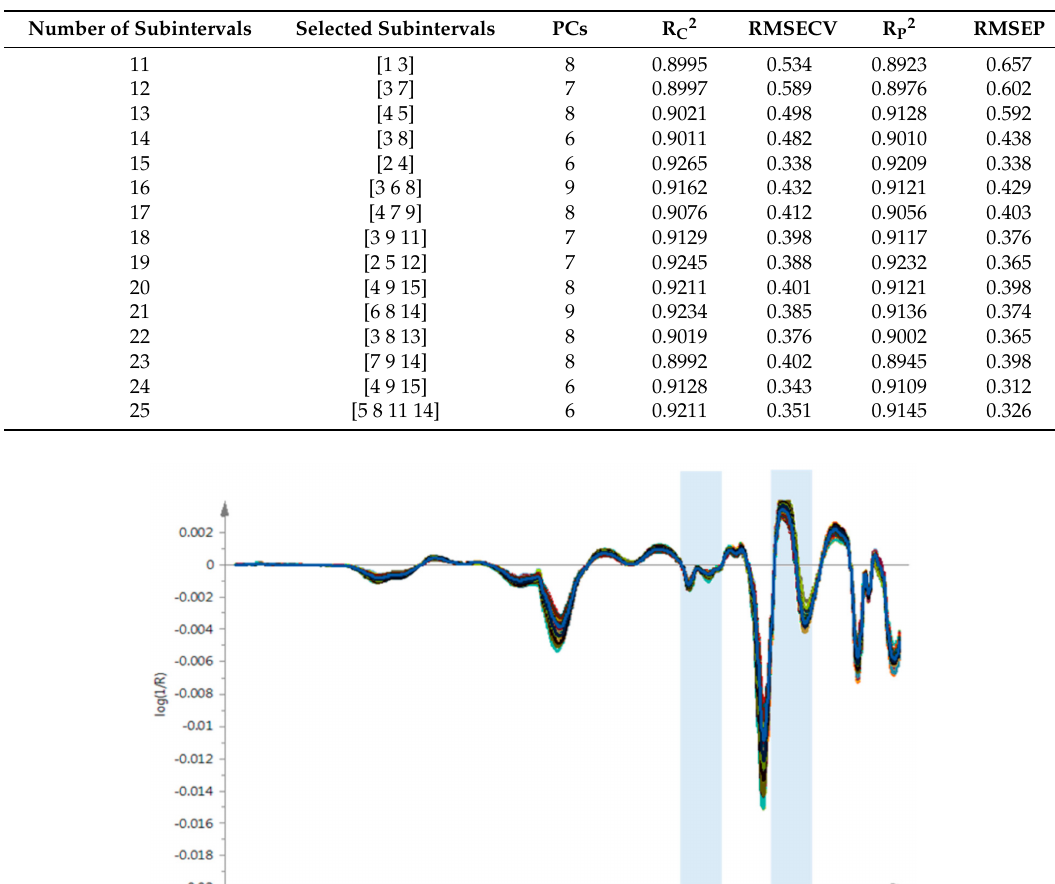
Table 7. Results of Si-PLS models with selected optimal spectral subintervals for PCC.